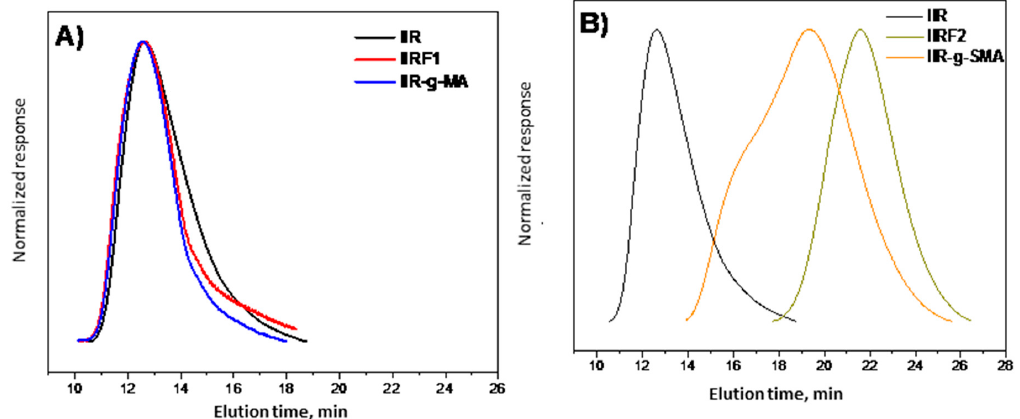
Figure 3. GPC of ( A ) IIR ( M n = 192,000 Da, PDI = 2.4), IIRF1 ( M n = 194,000 Da, PDI = 2.4), IIR- g -MA ( M n = 192,000 Da, PDI = 2.4); and ( B ) IIRF2 ( M n = 43,600 Da, PDI = 2.2), and IIR- g -SMA ( M n = 56,700, PDI = 2.75). The GPC of IIR is also included in Figure 3B. Figure 3A, corresponding to GPC chromatograms of IIR, IIRF1, and IIR- g -MA, shows a slight shift of IIRF1 (194,000 Da, PDI = 2.4) towards higher molecular weights with respect to IIR, which is attributed to a change in the hydrodynamic volume of IIR (192,000 Da, PDI = 2.4) with nitroxide, providing further indication of the functionalization reaction. The average molecular weight of IIRF1 increased only slightly (~1%) with respect to that of IIR, and this smooth modification is attributable to the dropwise addition of the initiator during the functionalization process, which permits a certain control of the concentration of the tert -butoxi radical formed in the reaction. Further, IIR- g -MA exhibited practically the same distribution and elution time as IIRF1, which is a desirable feature in the synthesis of a compatibilizer, since it is well known that the maleation of olefin polymers by the extrusion process in the presence of a peroxide initiator, especially in the case of IIR, is detrimental to the molecular weight of the polymer [7,15]. By using the methodology proposed here, it is possible to preserve the molecular weight distribution (MWD) of the original IIR. No broadening of the IIRF1 or the IIR- g -MA curves to low molecular weights is observed, indicating the absence of β -scission reactions; however, some broadening to higher molecular weight